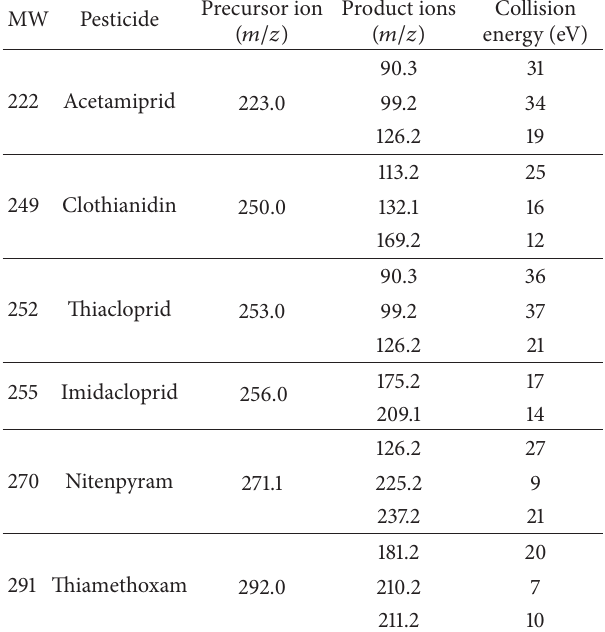
Table 1: UHPLC-MS/MS fragmentation of studied